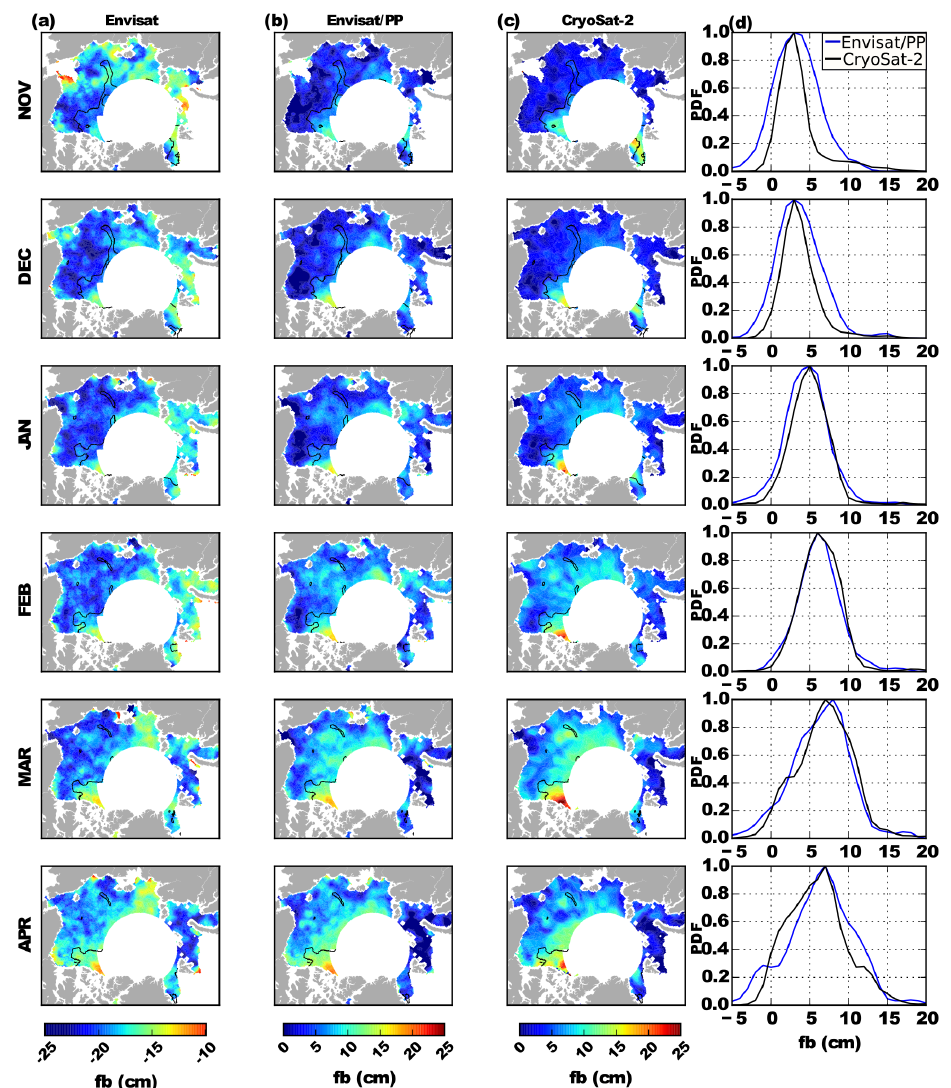
Figure 6. (a) Envisat, (b) Envisat/PP and (c) CryoSat-2 monthly freeboard maps shown for the November 2010–April 2011 period. The dark lines represent the isoline fraction of MYI equal to 0.7. (d) Probability distribution function (PDF) of Envisat/PP (blue) and CryoSat-2 (black) radar